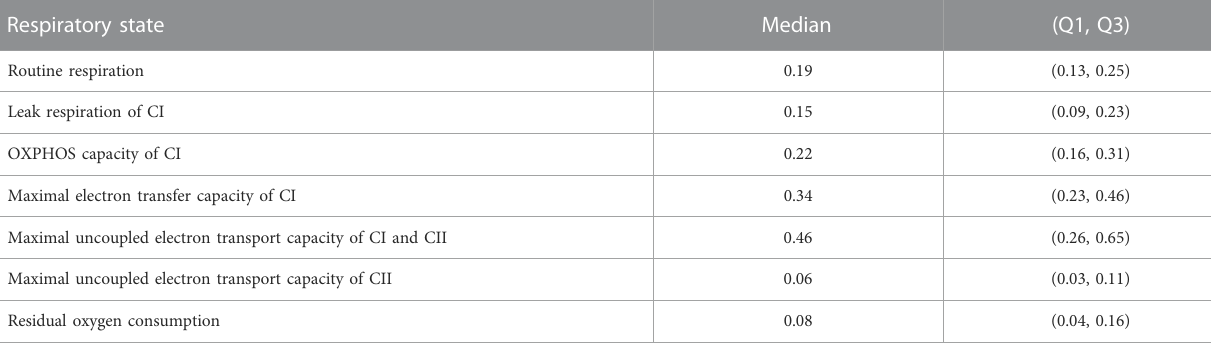
TABLE 3 Unadjusted fl ux control ratios of permeabilized platelet mitochondria